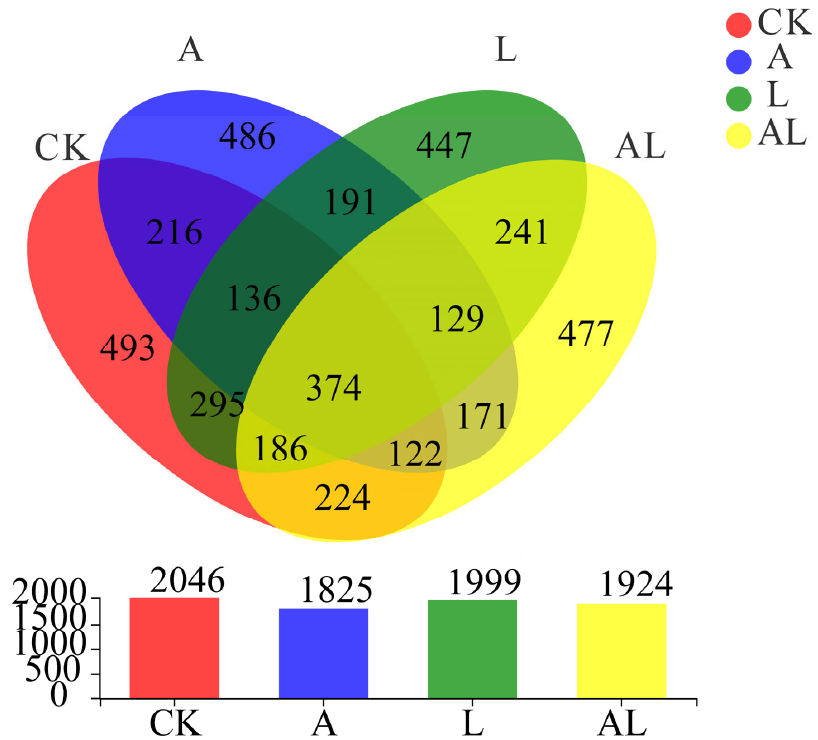
Figure 2. Composition of operational taxonomic units of the intestinal bacteria of honeybees. The number demonstrates the number of OTU, and different colors represent different groups.